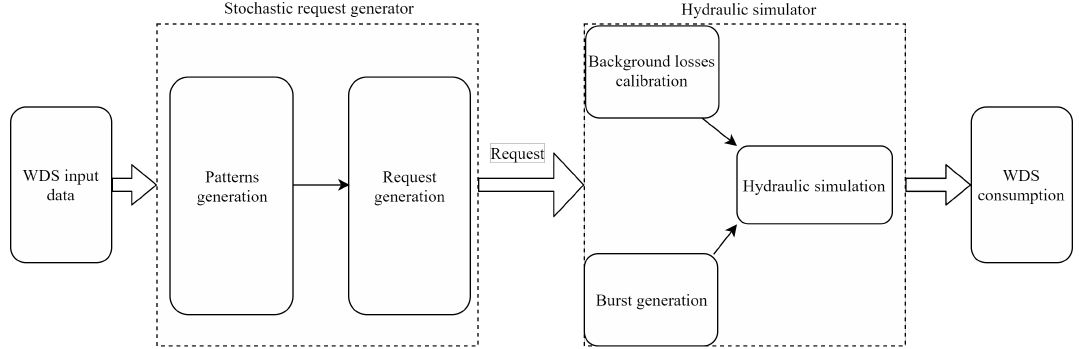
Figure 1. Flow chart of the proposed SHtsG for developing bursts detection